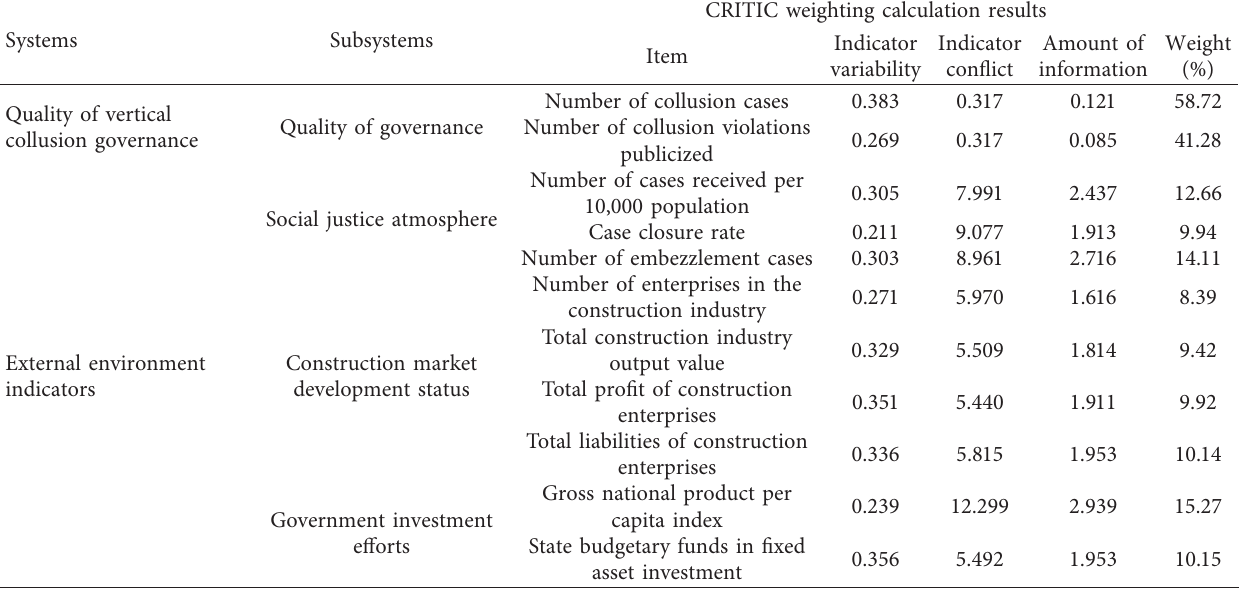
Table 3: CRITIC method weighting results.